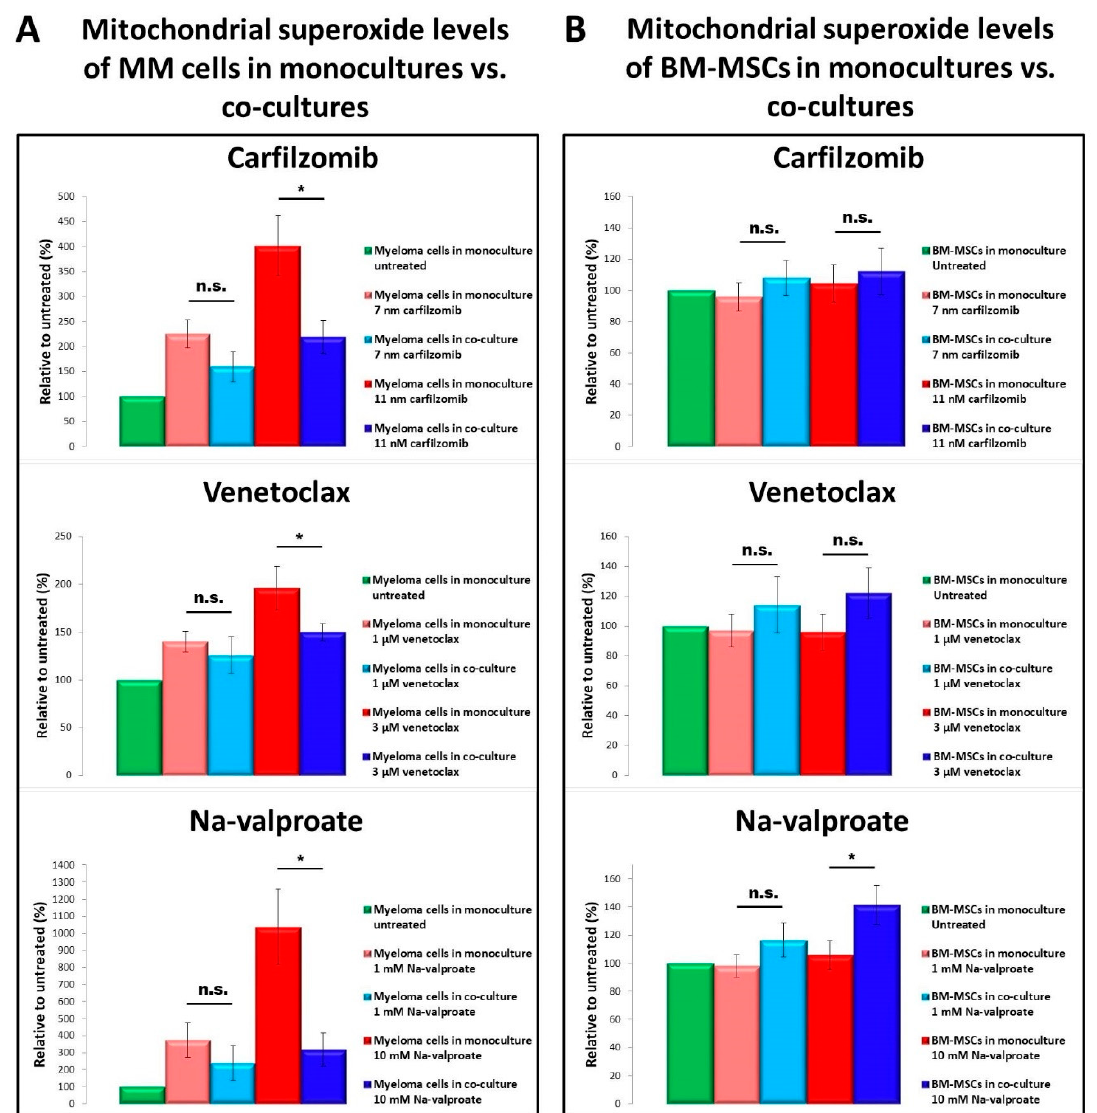
Figure 4. Mitochondrial superoxide levels in MMs and BM-MSCs. The cells were treated with various drugs in mono- or co-cultures and cultured for 24 h ( A , B ). After washing, all cells of the co-cultures were labeled with MitoSOX Red for 10 min at 37 °C. After subsequent washing, superoxide levels were analyzed by flow cytometry within the CD38 + MM cell population ( A ) or within the CD146 + BM-MSC population ( B ) using anti-CD38 Alexa Fluor 488 or anti-CD146 Alexa Fluor 488 monoclonal antibodies, respectively. The values are presented as mean ± standard deviation, p values < 0.05 were considered significant ( * ) while p values > 0.05 were considered non-significant (n.s.). The results are representative of three independent experiments for one patient.